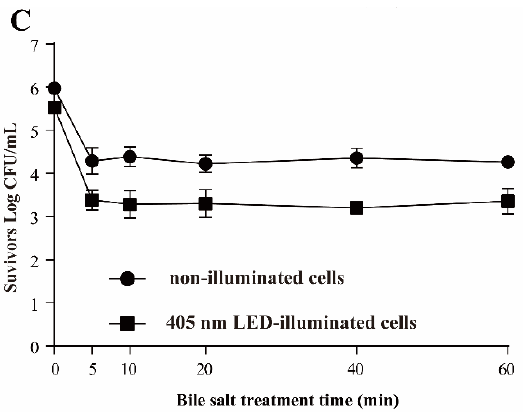
Figure 7. Survival curves of S . Typhimurium in 1% ( A ), 2% ( B ), and 3% ( C ) bile salts solution. ( ● ) non-illuminated cells, ( ■ ) 405 nm LED-illuminated cells.